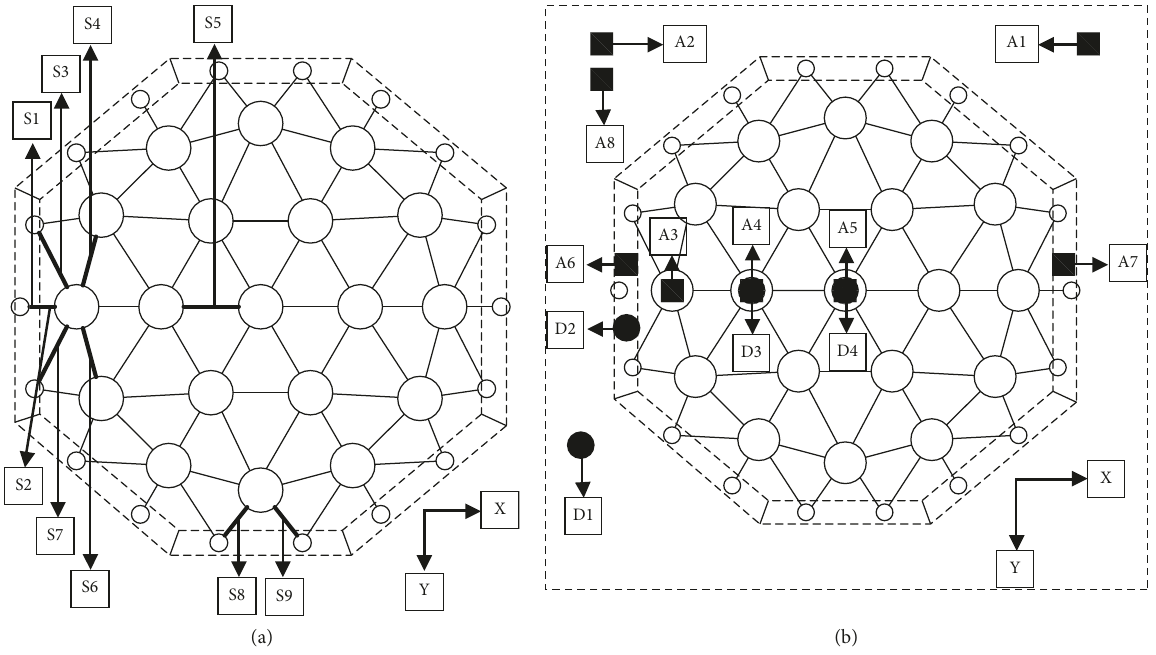
Figure 2: Arrangement of measuring points. (a) Arrangement of strain gages; (b) arrangement of the accelerometers and displacement sensors.